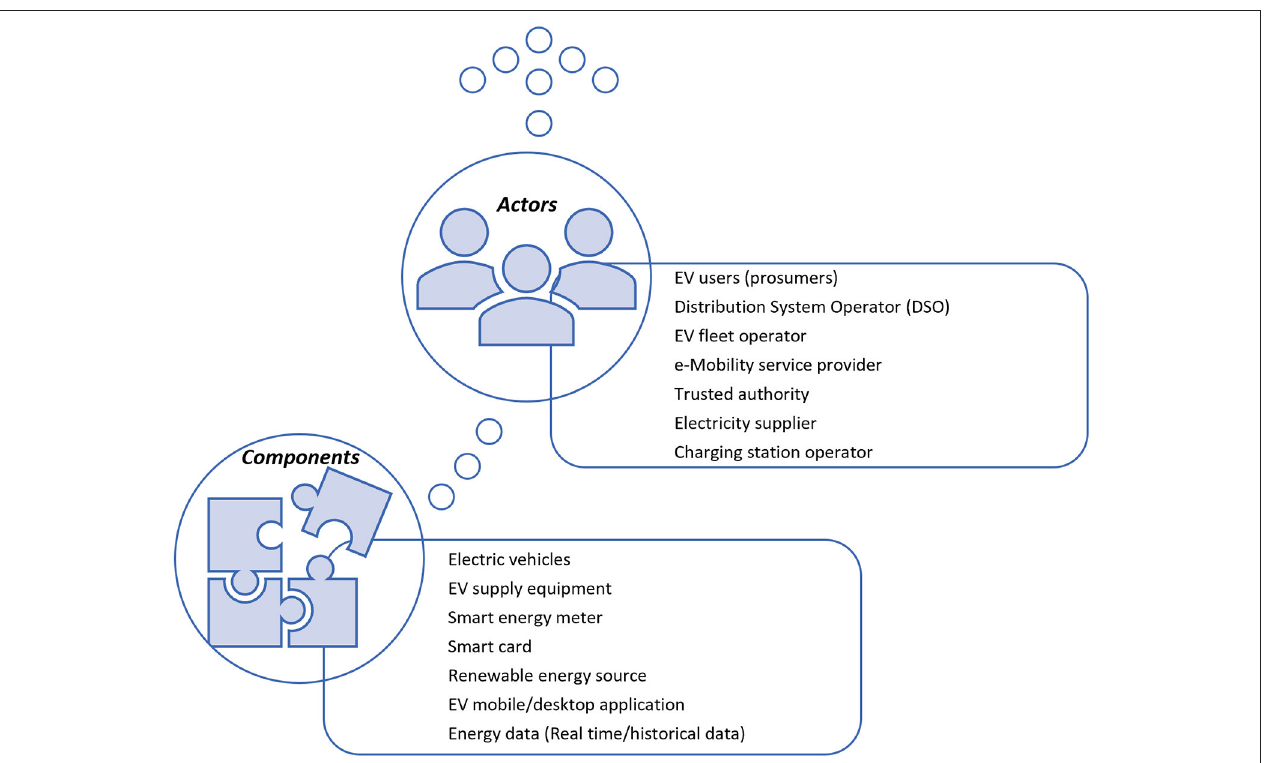
FIGURE 2 | Proposed energy as a service business model for EV integration in smart